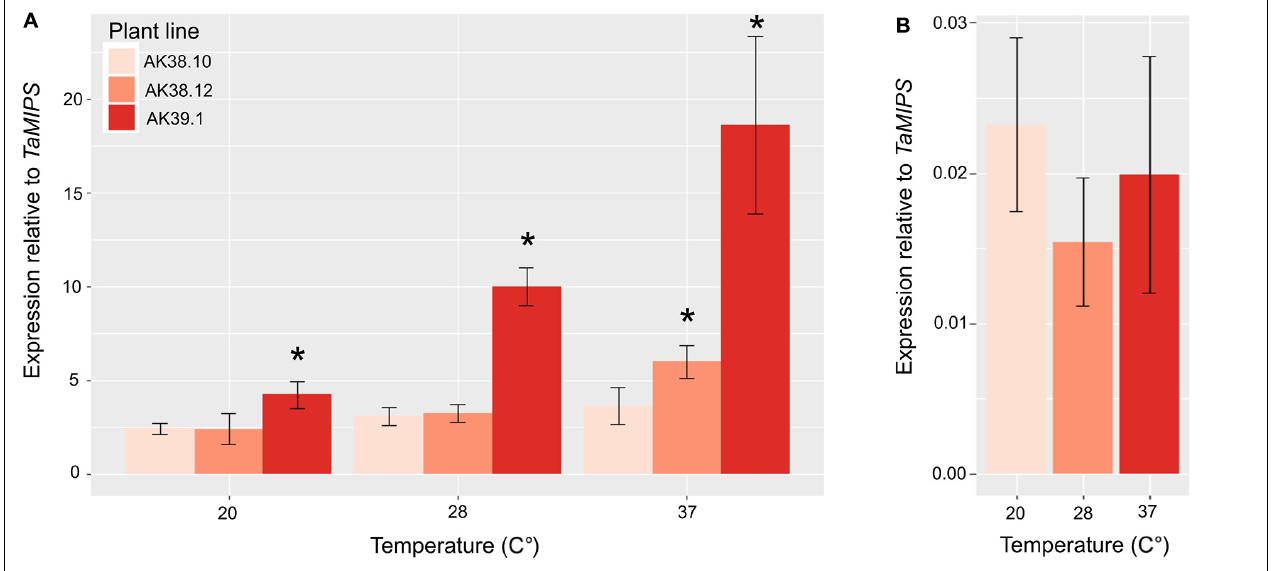
FIGURE 1 | Expression of wheat optimized Cas9 under the control of the either the ZmUbi promoter (A) in three different transgenic lines (AK38.10, High; AK38.12, Medium; and AK39.1 Low/No mutations) or the OsActin promoter (B) GE1.2 (Howells et al., 2018), with previously identified different mutations rates in the T 0 transgenic line. Each line was grown under three different temperatures for 7 days and Cas9 expression was measured. Cas9 expression is normalized to TaMIPS expression. Shown is the average of three biological replications with three plants in each biological replicate. Star (*) corresponds to a p val. < 0.05 relative to the low expressing line